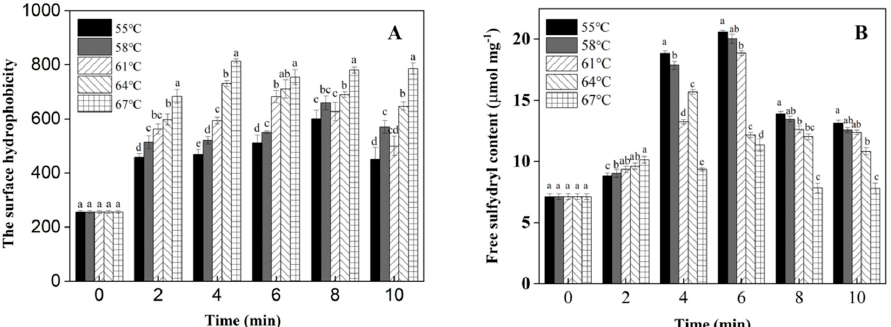
Figure 4. The effect of different heating treatment conditions on the surface hydrophobicity and sulfhydryl group content of LWE. ( A ): surface hydrophobicity; ( B ): sulfhydryl group content; a–d means within a row with different superscript letters indicate significant differences ( p < 0.05). Mean results of 3 independent trials ± standard deviation.